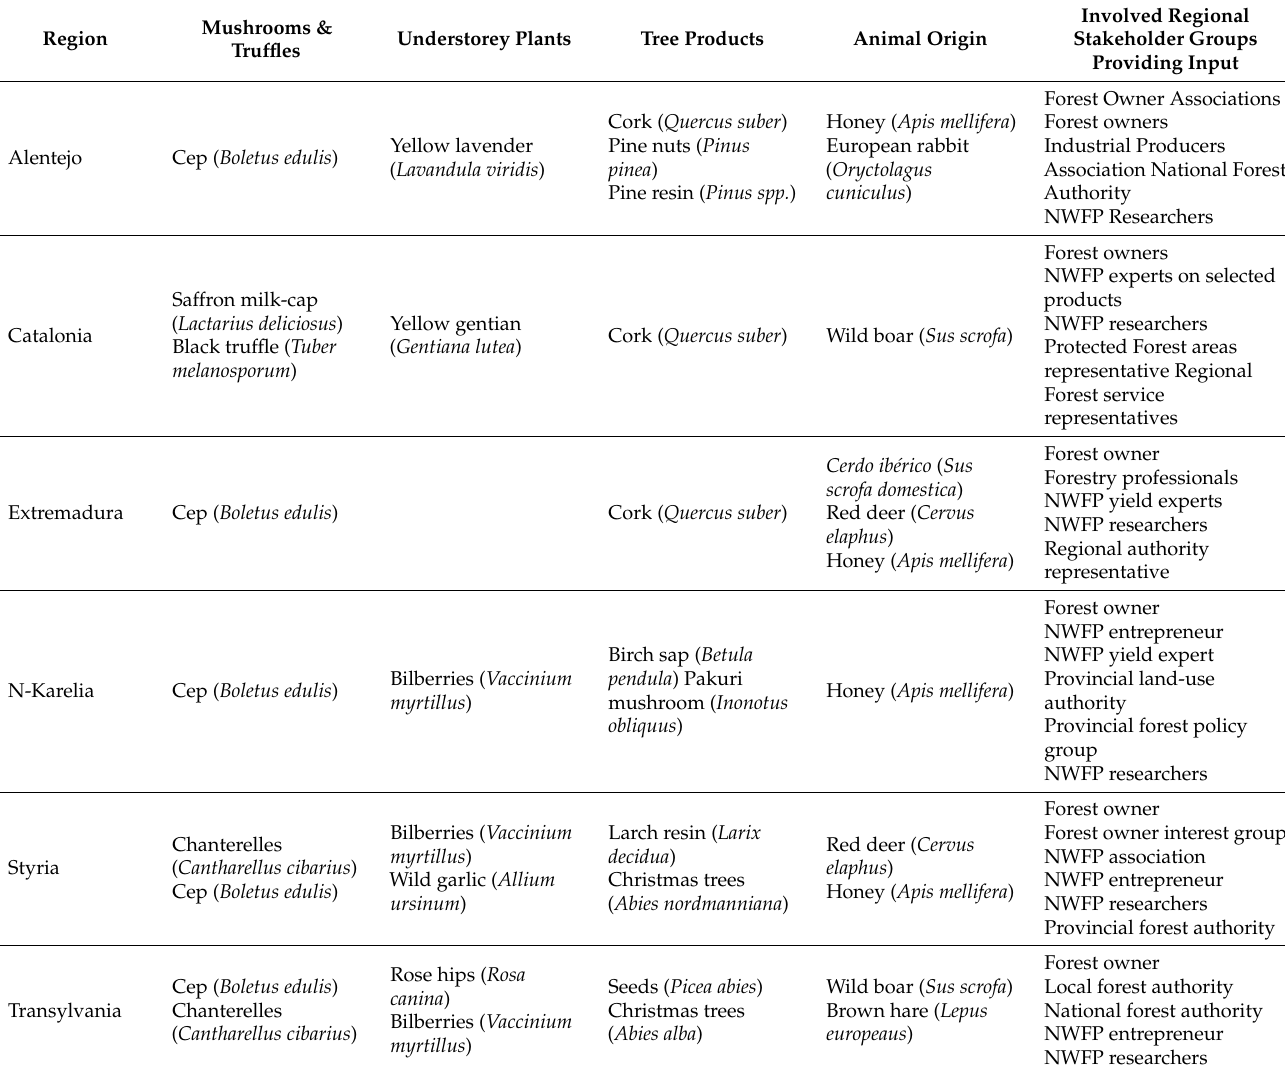
Table 2. NWFPs (including species information as Latin names) investigated in the case study regions split into four NWFP categories. Additionally, information on the number and type of experts is included, as well as on the stakeholders involved in the evaluation